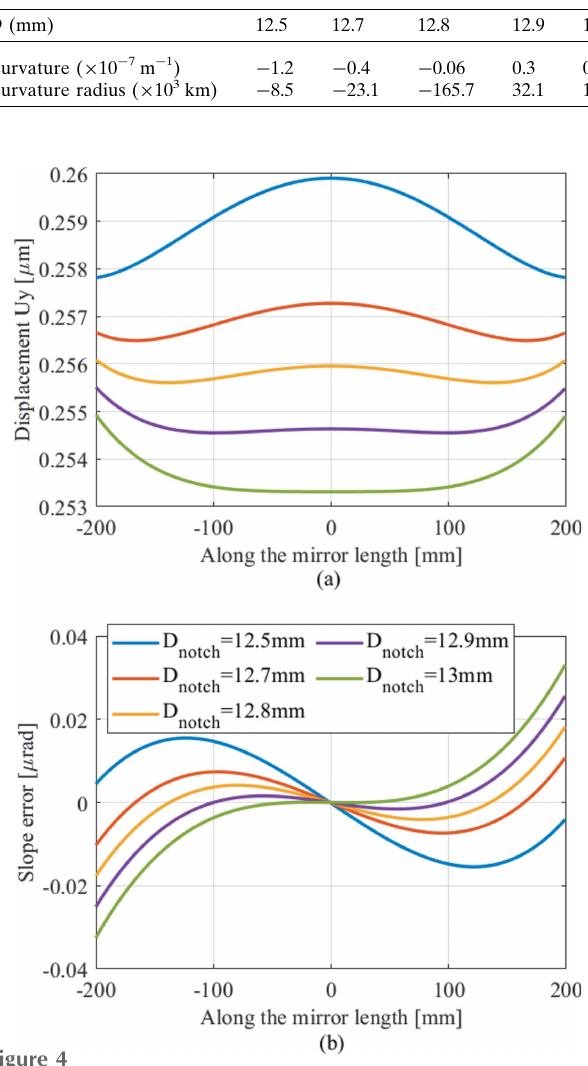
Figure 4 Result of the meridional thermal deformation for different D . Displace- ment U y ( a ) and slope error ( b ) along the meridian of the footprint are plotted. As D increases, thermal deformation changes from convex to concave.